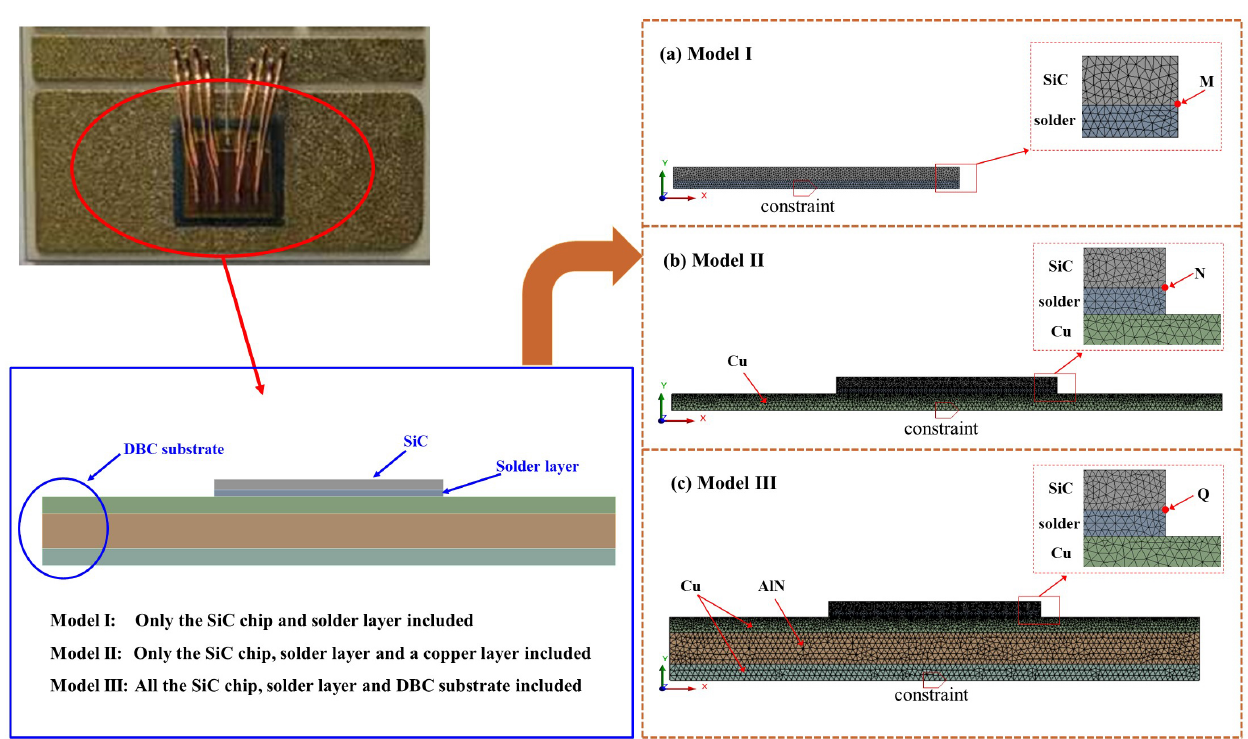
Figure 1. The finite element model of ( a ) chip–solder layer structure, ( b ) chip–solder layer and copper layer structure and ( c ) chip–solder layer and DBC substrate